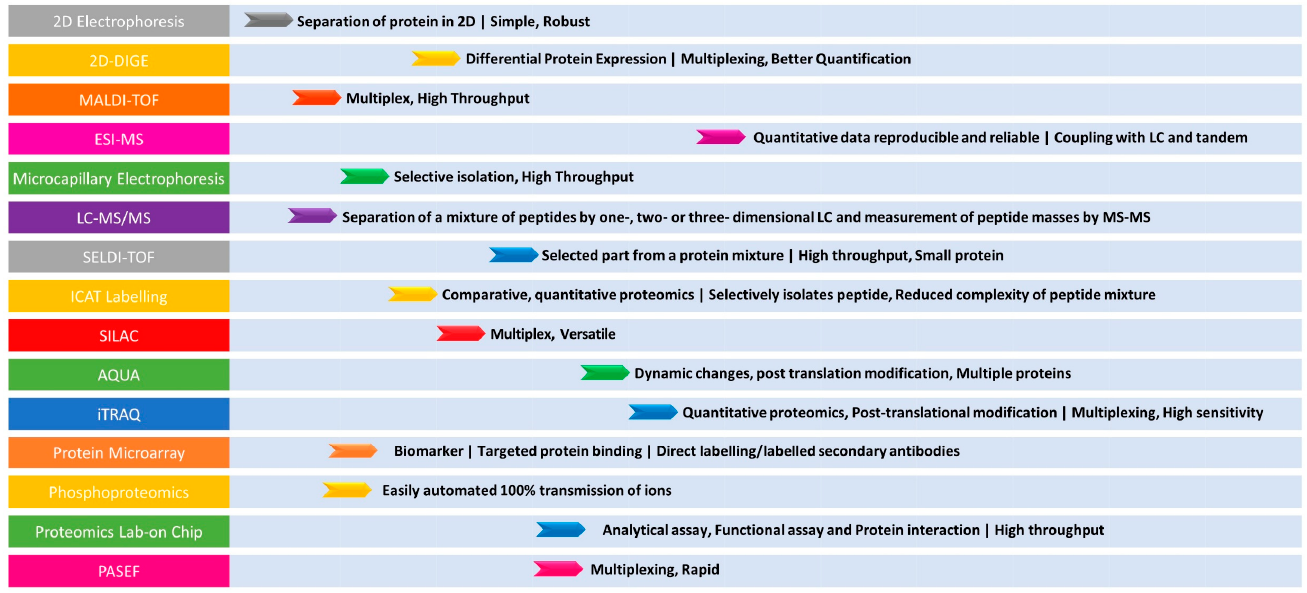
Figure 2. Summary of the advantages for various proteomic tools in AMR detection . The ( left ) panel indicates the techniques. The ( right ) panel indicates the application and its advantage.